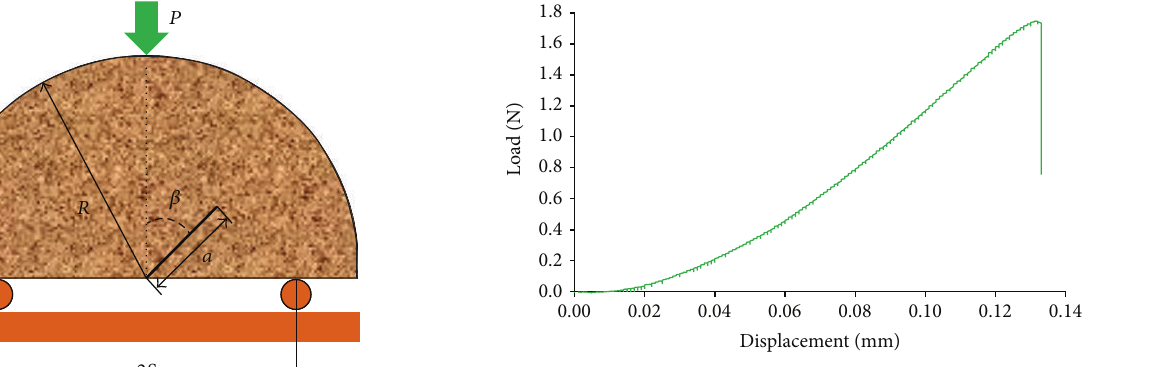
Figure 2: Typical load-displacement